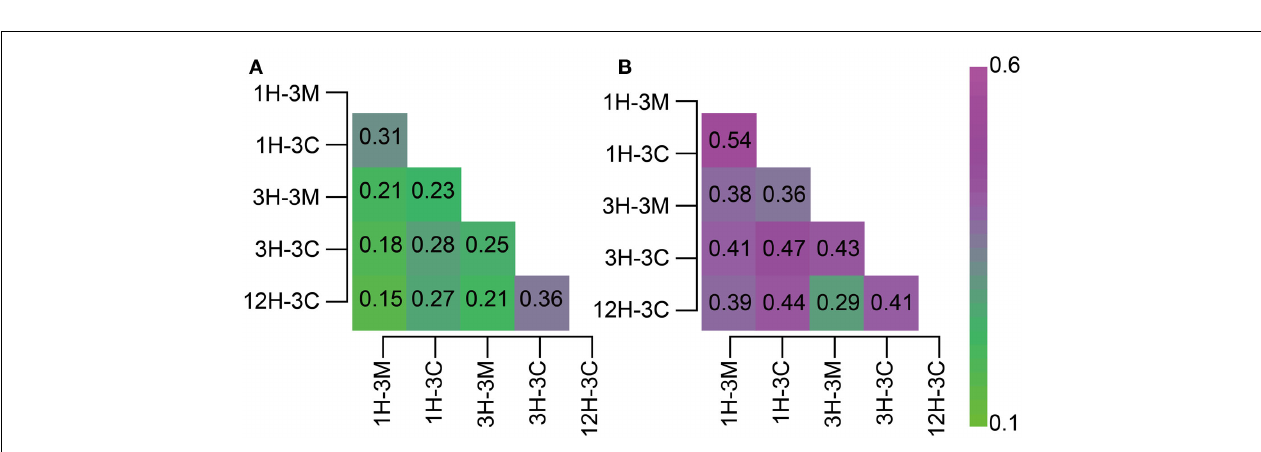
Frontiers in Microbiology | Extreme